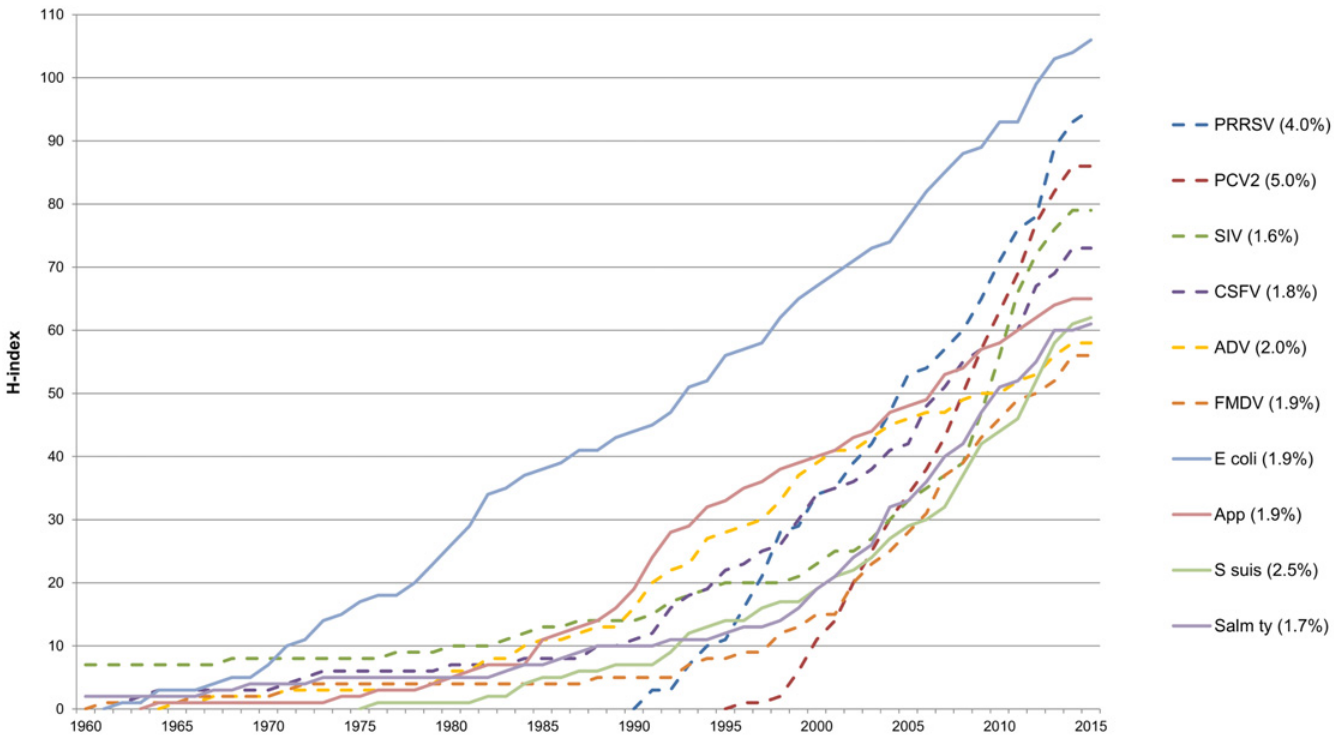
Fig 3. Evolution of H-index scores. Evolution of H-index scores by year from 1960 to March 2015 for the ten pig infectious agents with highest H-index, and mean of the percentage of increase by year from first paper published. PRRSV: Porcine reproductive and respiratory syndrome virus ; PCV2: Porcine circovirus type 2 ; SIV: Swine influenza virus ; CSFV: Classical swine fever virus ; ADV: Aujeszky ’ s disease virus ; FMDV: Foot-and-Mouth disease virus ; E coli: Escherichia coli; App: Actinobacillus pleuropneumoniae; S suis; Streptococcus suis; Salm ty; Salmonella Typhimurium.